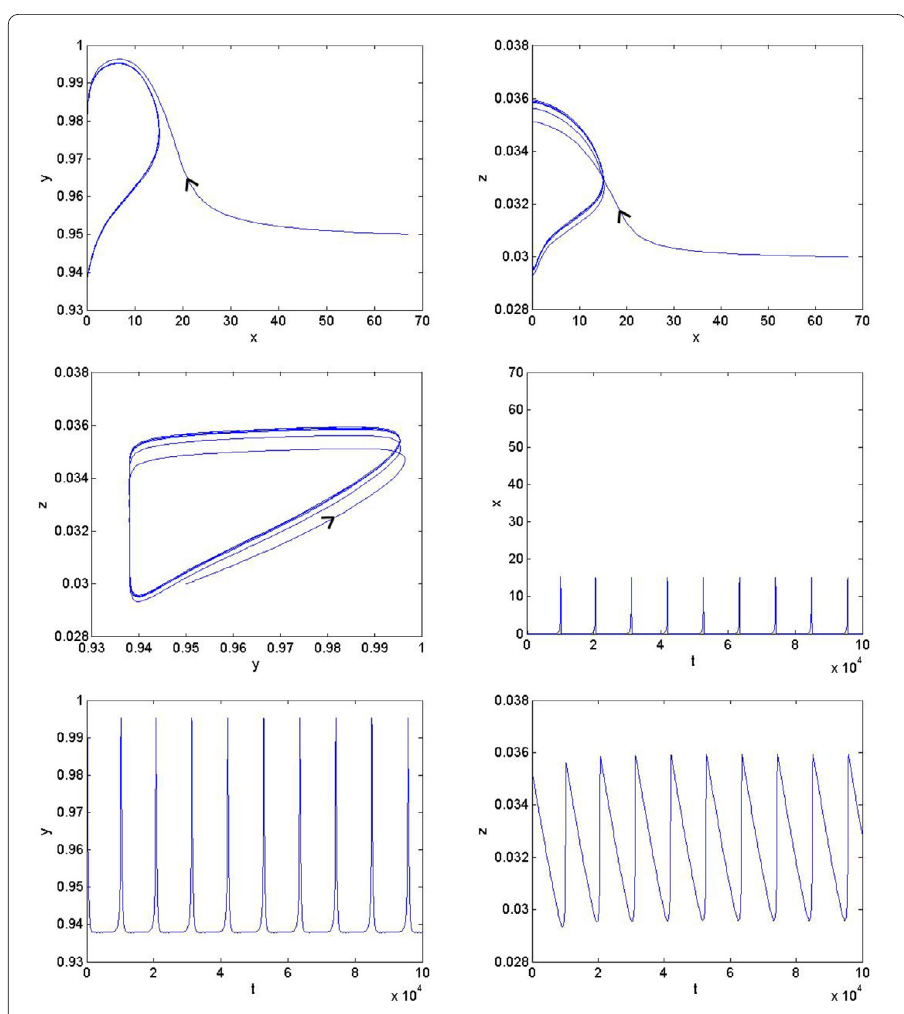
Figure 6 A computer simulation of the system of Eqs. (4)–(6) with c 1 = 0.9 day –1 , c 2 = 0.95 day –1 , c 3 = 0.239 day –1 , c 4 = 0.91 day –1 , c 5 = 0.49 day –1 , k 1 = 67, k 2 = 0.02, k 3 = 0.9, h 1 = 0.024, h 2 = 0.063, e solution trajectory tends towards a limit cycle as theoretically predicted